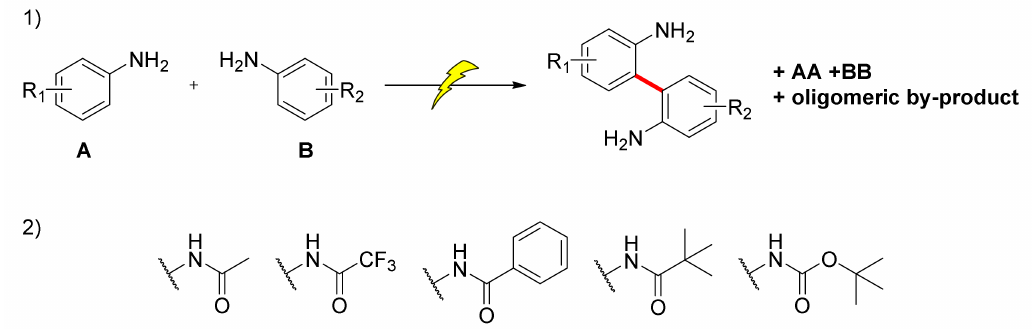
Figure 3. ( 1 ) Direct oxidation of aniline. ( 2 ) Amine protecting group used by Waldvogel and